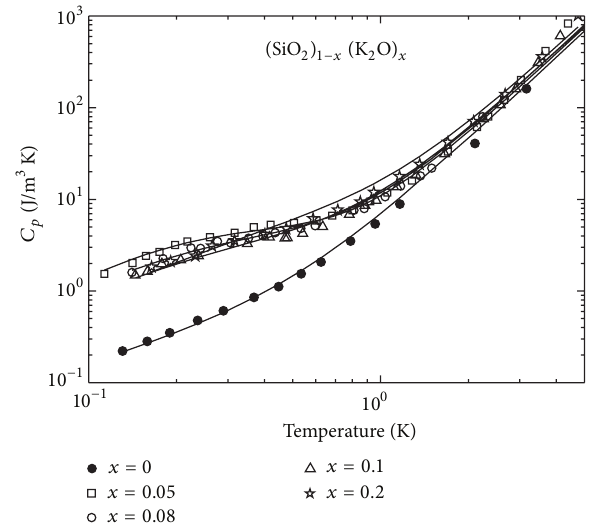
Figure 12: The temperature dependence of the heat capacity for 𝑎 - SiO 2 (blackcircles)andforthe ( SiO 2 ) 1−𝑥 ( K 2 O ) 𝑥 glasses[24].Thefull lines are our theoretical curves, as generated by (31).